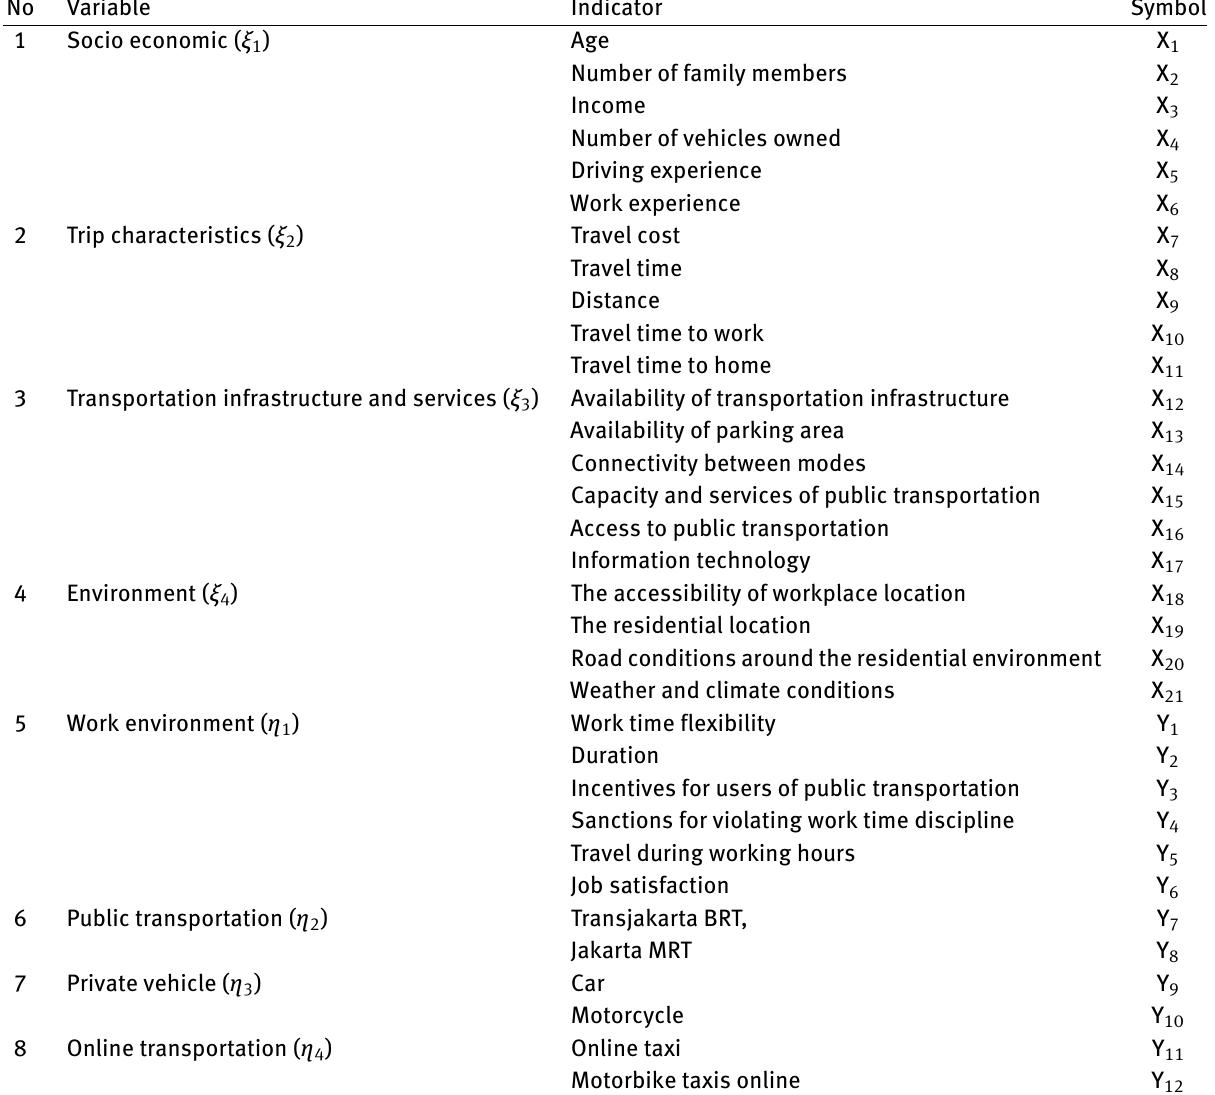
Table 1: Variables and indicators in the model No